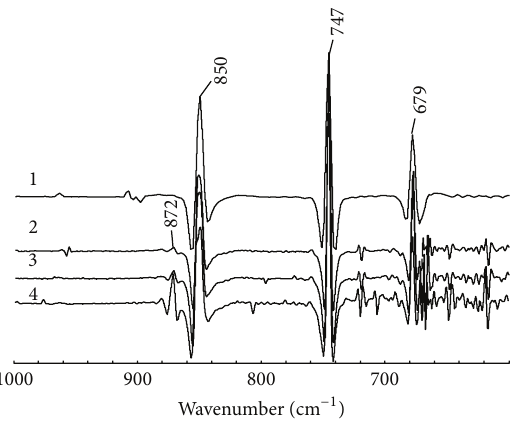
Figure 6: Second derivative FTIR spectra of La 2 (CO 3 ) 3 ⋅ 8H 2 O (line 1), La 2 (CO 3 ) 3 ⋅ 8H 2 O containing 1wt% La(OH)CO 3 (line 2), La 2 (CO 3 ) 3 ⋅ 8H 2 O containing 2 wt% La(OH)CO 3 (line 3), and La 2 (CO 3 ) 3 ⋅ 8H 2 O containing 5 wt% La(OH)CO 3 (line 4) in the fingerprint region (1000–600cm −1 ).